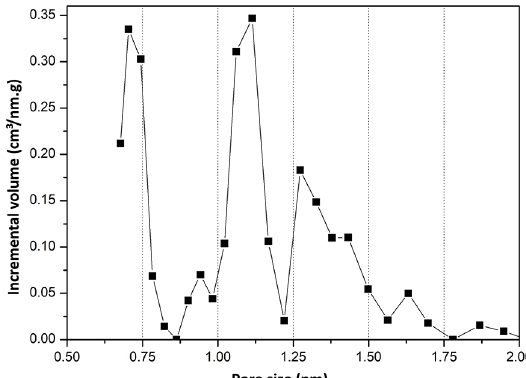
Figure 9. Pore size distribution of the silica layer by DFT